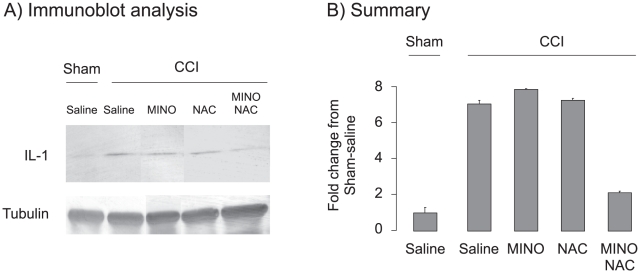
MINO or MINO plus NAC prevented IL-1β formation when administered before moderate CCI.Rats were dosed with saline, MINO, NAC or both drugs 3 hours prior to sham- or moderate CCI. The rats were sacrificed one hour after surgery; and IL-1β and tubulin levels were assayed from protein extracts prepared from hippocampus. Panel A, Representative Il-1β and tubulin immunoblot analysis, Panel B, Summary of immunoblot analysis.